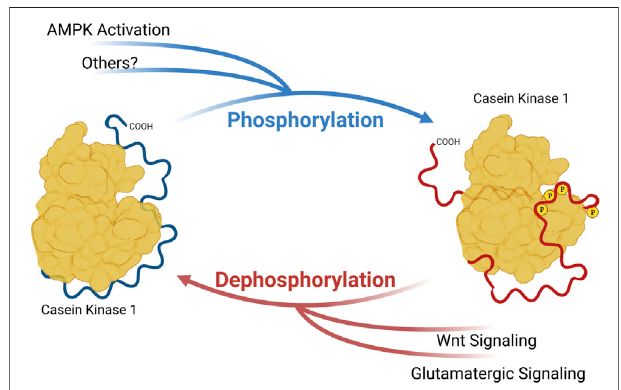
FIGURE 1 | Phosphorylation of Casein Kinase 1 Carboxyterminal tail in fl uences substrate preference. Phosphoryl groups on the carboxyterminal tailmay interact withanion-bindingpockets onCK1,alteringtheconformation of substrate binding cleft and substrate preference. Created with Biorender.